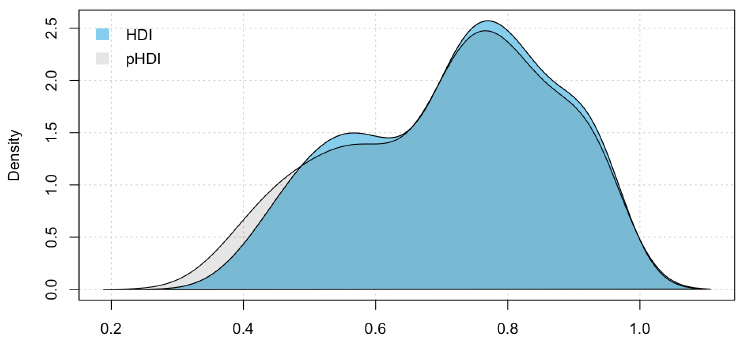
Figure 4. Density distribution of HDI and pHDI .